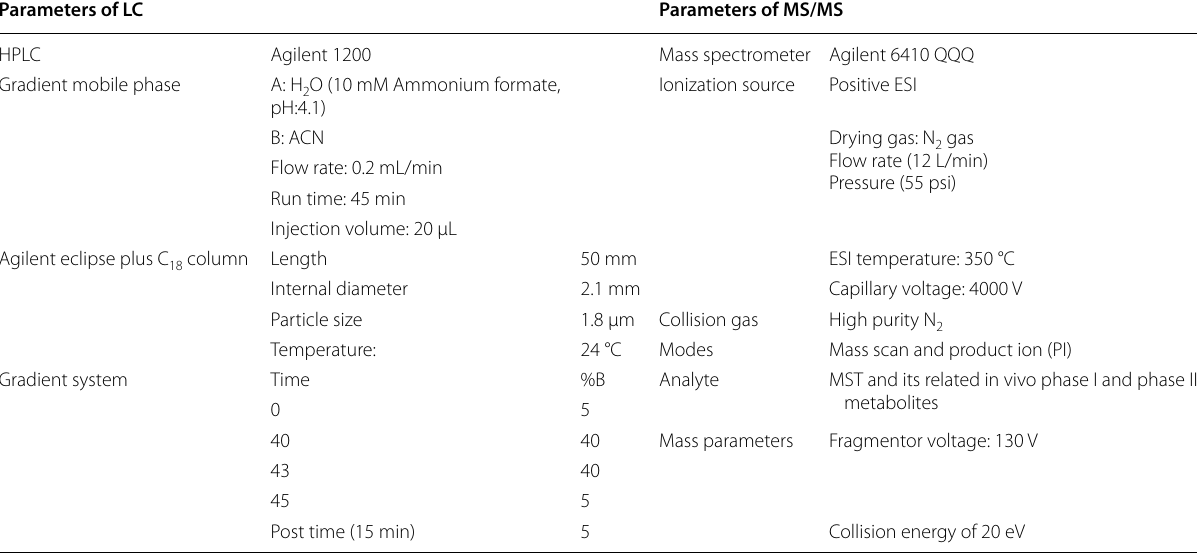
Table 2 Adjusted parameters of the supposed LC–MS/MS methodology Parameters of